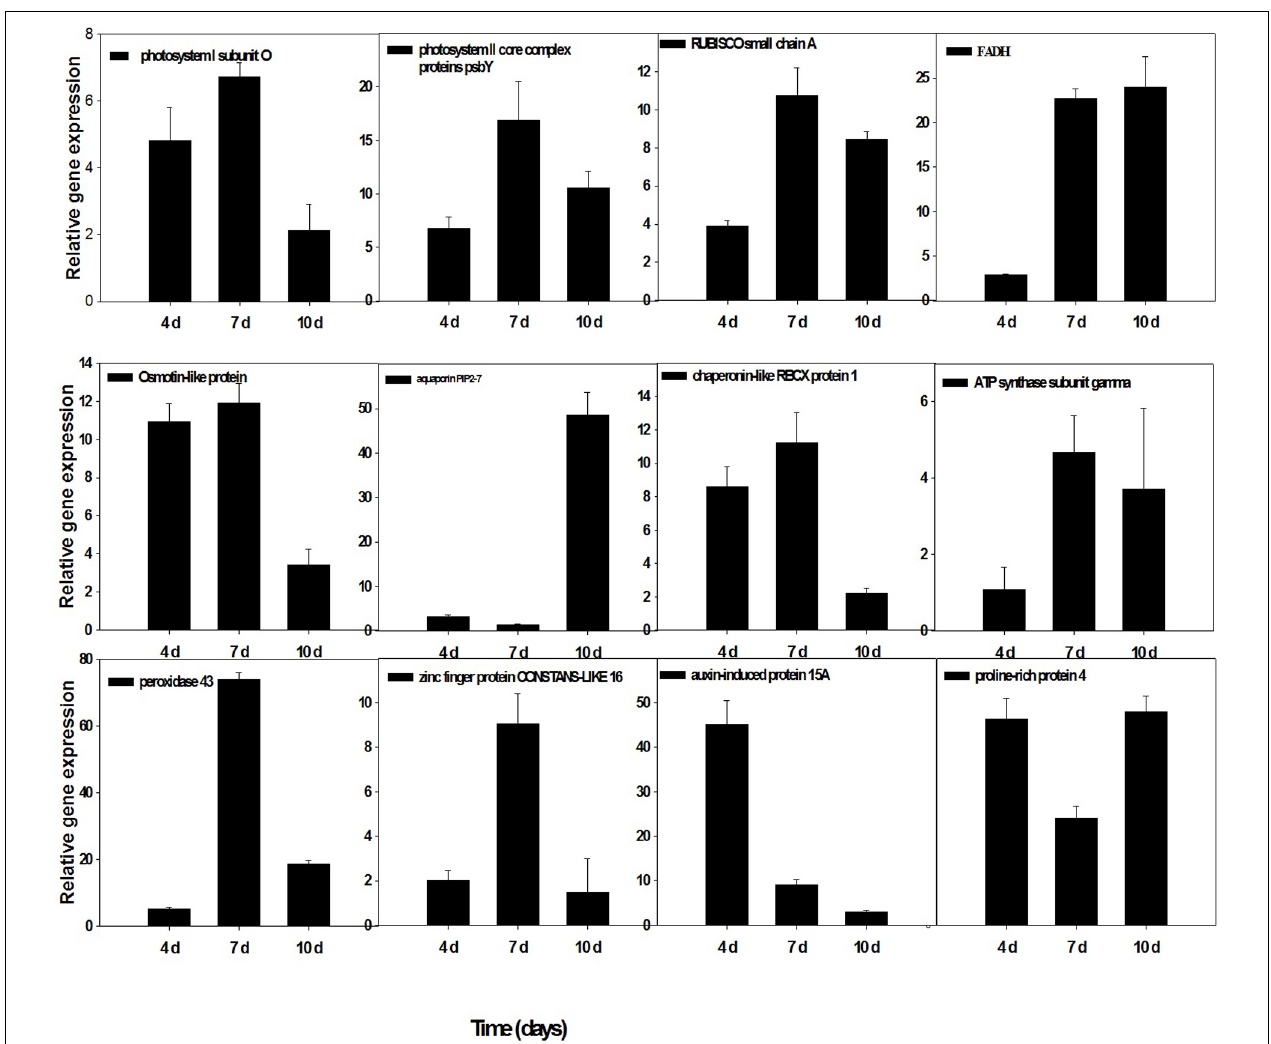
FIGURE 7 | qRT-PCR validation of selected genes showed significant difference in their expression in T. harzianum -treated and drought-stressed when compared with drought-stressed at three different time intervals (4, 7, and 10 days). Error bars show ± SD among the biological